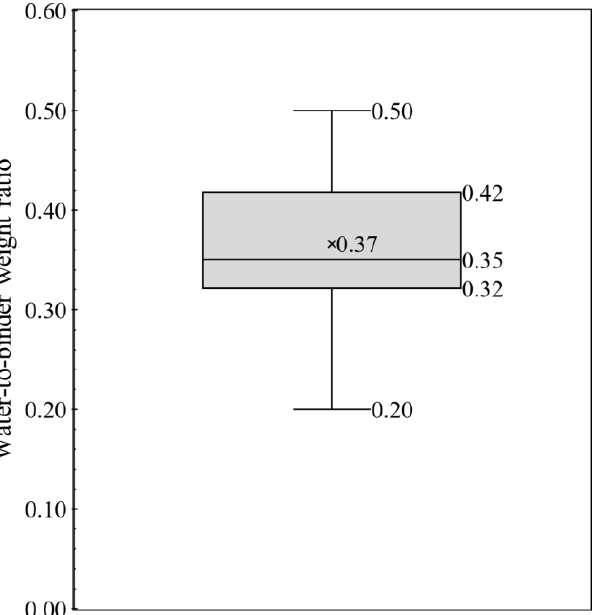
Figure 6. Whiskers box of water-to-binder weight ratio for 157 mixtures design based on literature survey (data source: [30,44 – 85,89 – 92]).